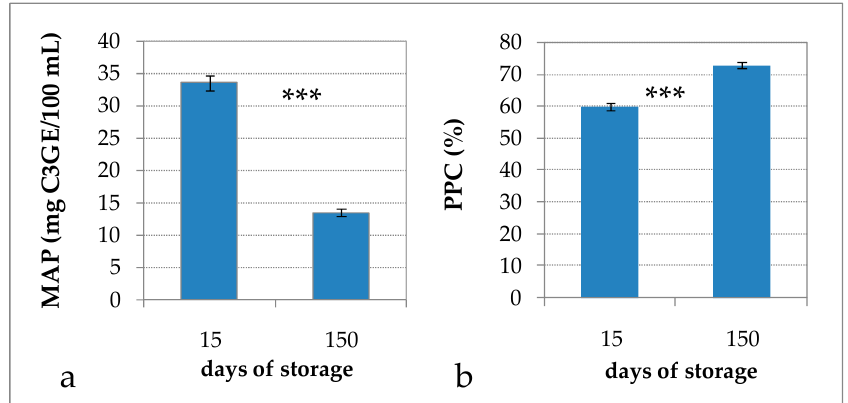
Figure 1. ( a ) Monomeric anthocyanin pigments (MAP); and ( b ) percent polymeric color (PPC) of mix-RCW drink after 15 and 150 days of storage. Data are expressed as the mean ± standard error ( n = 6). *** Significance of Student’s t -test: exact p -value: <0.0001.